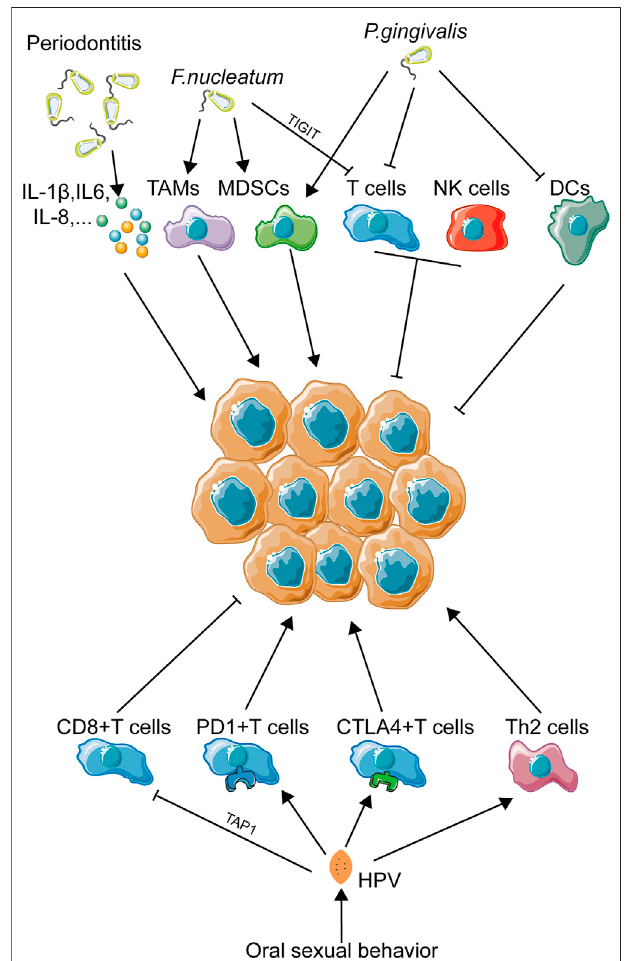
FIGURE 4 | Immune landscape in oral pathogen – related OSCC. This fi gure depicts the immune landscape caused by oral pathogens, including bacteria and viruses, in OSCC development. Immune regulation was the main activity upon oral pathogen exposure. As infectious factors have been proven to be more and more important in OSCC initiation and progression, immune activities induced by OSCC-related pathogenic bacteria and viruses might also be a crucial part contributing to OSCC